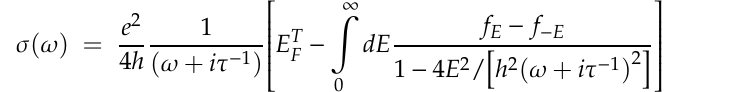
Figure 13. Radiation e ffi ciency corresponding to characteristic modes.